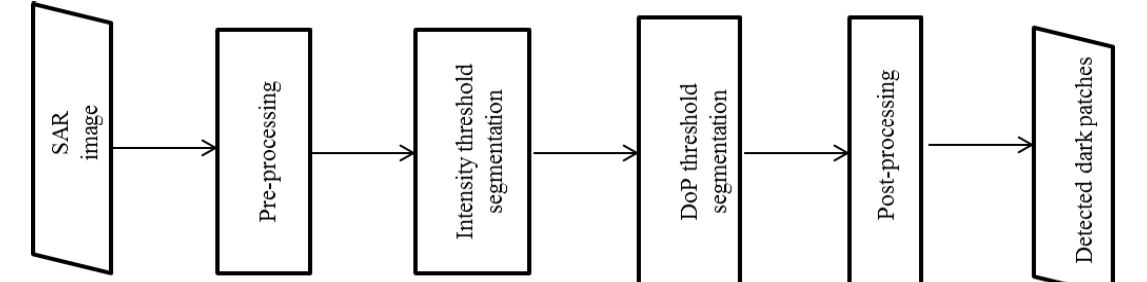
Figure 1. flowchart of the proposed method First, a 3×3 Gaussian filter with a standard deviation of 0.5 is used to reduce the speckle effects of the span image. This results in a more stable intensity threshold (Shu et al. 2010). Then, the histogram of the intensity image is adjusted using a piecewise linear transform. The lowest 1% of all pixel values are specified as 0, while the highest 1% are specified as 255. The remaining pixel values are stretched within the range from 0 to 255 using a linear transformation. This causes enhancing contrast between dark patches and the